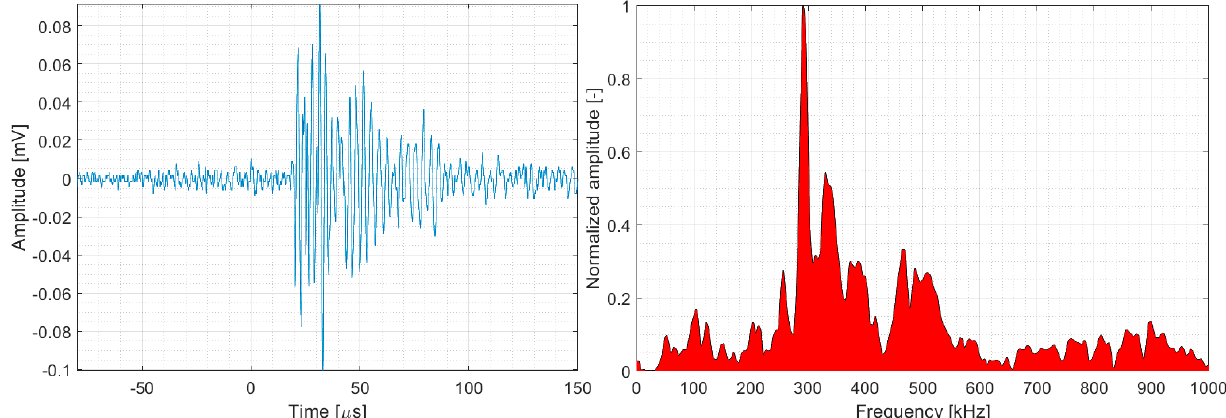
Figure 28. Representative AE signal of fibre/matrix debonding (DWC 454 dataset).